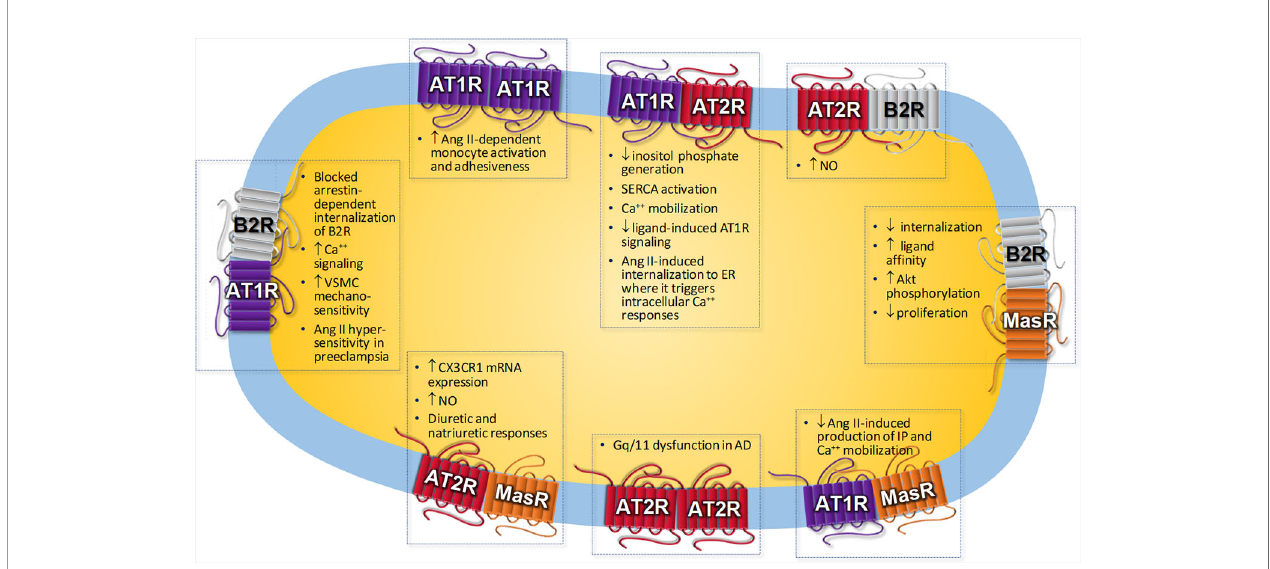
FIGURE 1 | Biological responses associated to angiotensin receptors homo- or heteromerization. AD, Alzheimer ’ s disease; Ang II, Angiotensin II; AT1R, Ang II receptor type 1; AT2R, Ang II receptor type 2; B2R, Bradykinin receptor type 2; CX3CR1, CX3C chemokine receptor; ER, endoplasmic reticulum; IP, inositol phosphate; NO, nitric oxide; SERCA, sarco/endoplasmic reticulum Ca2+-ATPase; VSMC, vascular smooth muscle